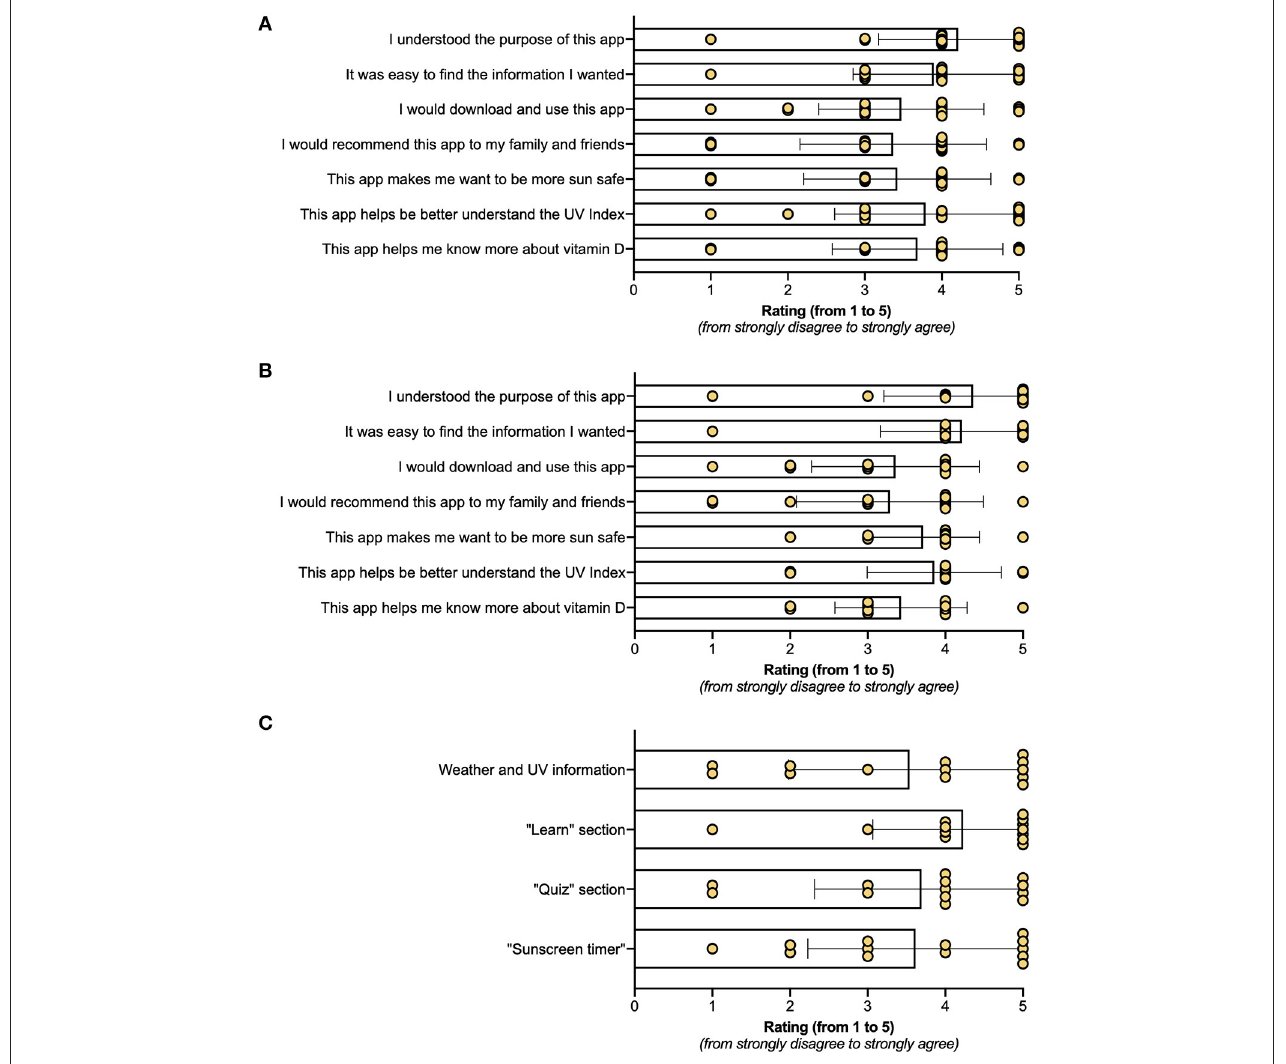
FIGURE 6 | Co-researcher assessments of the wireframe and fully working protype of Sun Safe app. After using the (A) wireframe or (B) fully developed Sun Safe app for 20min in Workshops 2 and 3 (respectively), co-researchers were asked to complete a subjective seven-item assessment. In (A) , responses from 18 co-researchers (one on 2 occassions), and in (B) , responses from 14 co-researchers. In (C) , co-researchers attending Workshop 3 were asked to rate four main “features” of the Sun Safe app (responses from 13 co-researchers only). Each item/feature was assessed using a 5-point Likert scale (from 1 star = strongly disagree to 5 stars = strongly agree), with bars denoting mean values and error bars denoting SD, with individual responses also